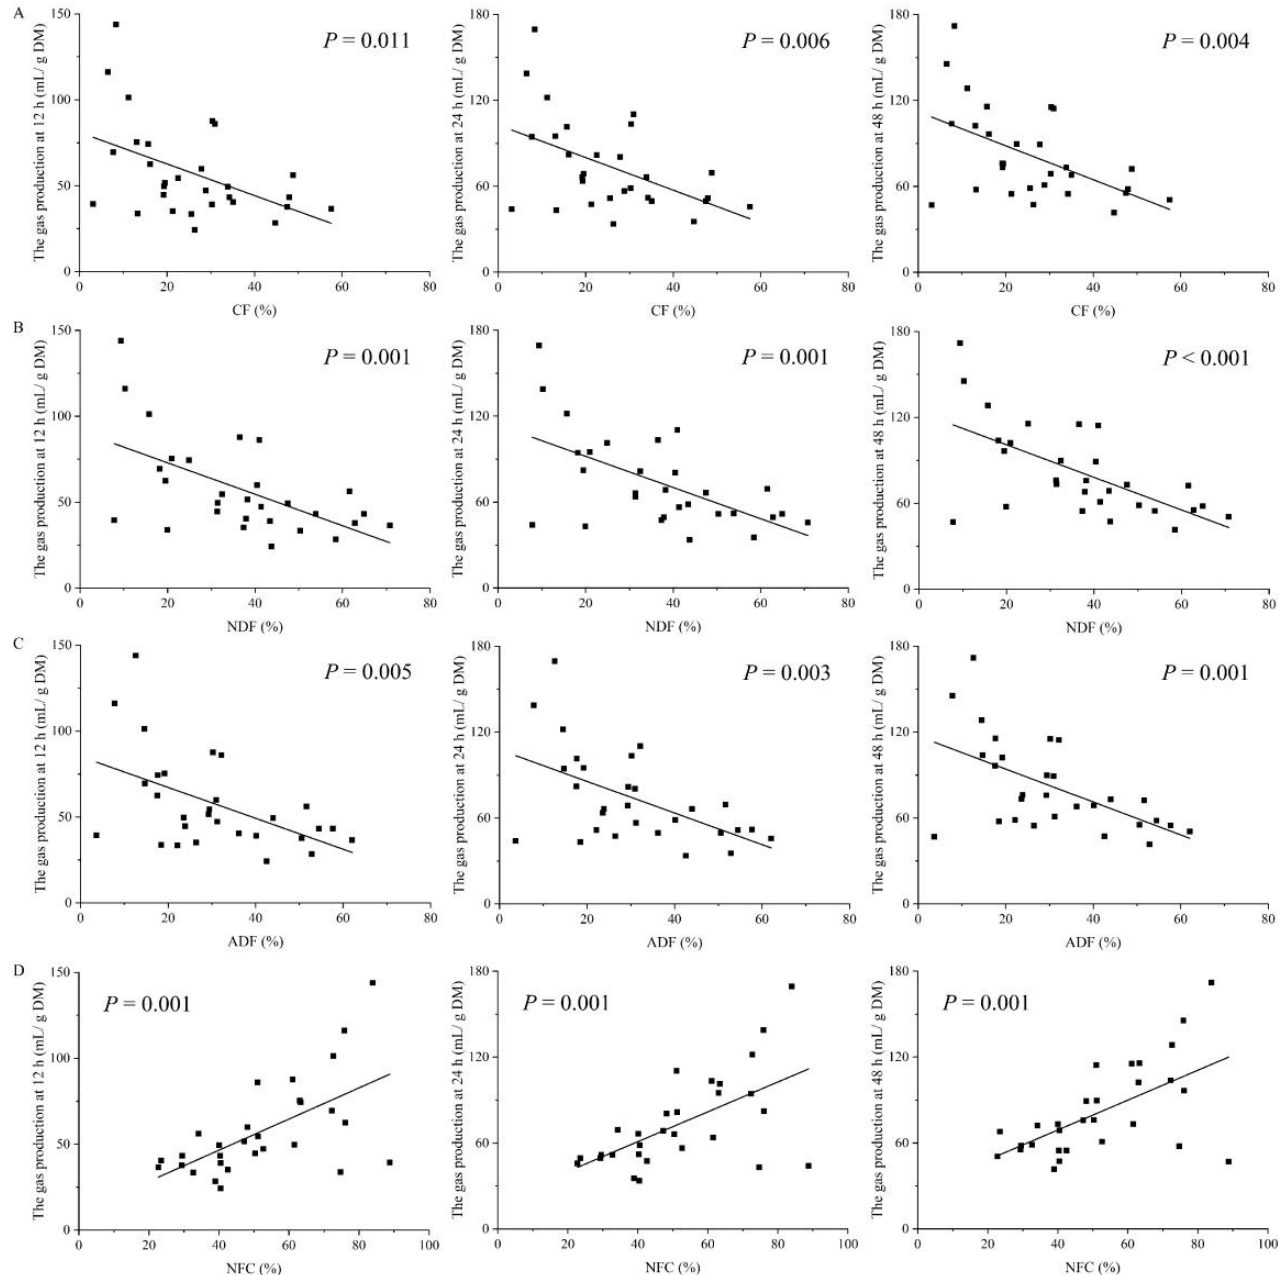
Figure 2. Correlation analysis of gas production at 12 h, 24 h, and 48 h of incubation with crude fiber (CF; ( A )), neutral detergent fiber (NDF; ( B )), acid detergent fiber (ADF; ( C )), and non-fiber carbohydrates (NFC; ( D )). p < 0.05 indicates significant correlation.